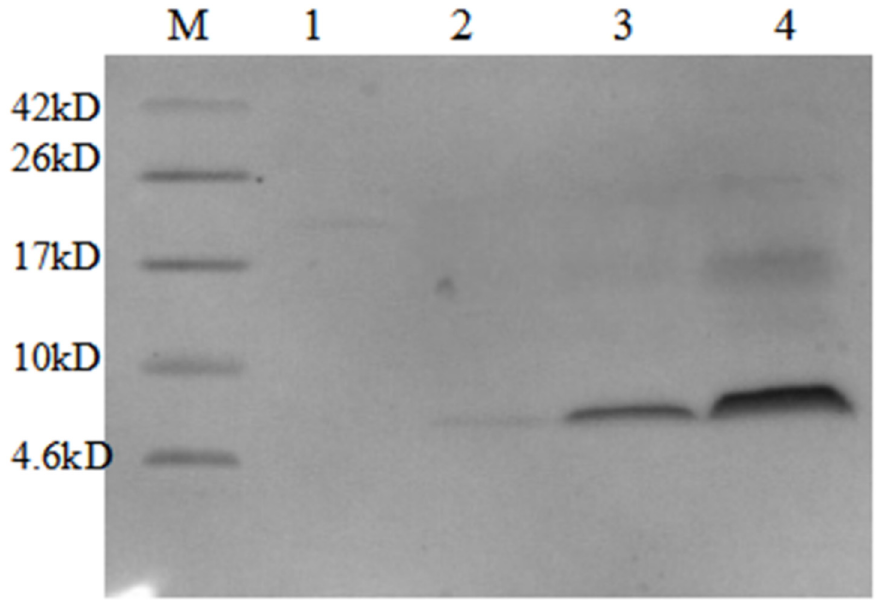
Figure 12. Tricine SDS-PAGE analysis of purification of AMP 13. M, protein molecular weight marker. Lane 1–4, the purified AMP13 produced by P. pastoris .